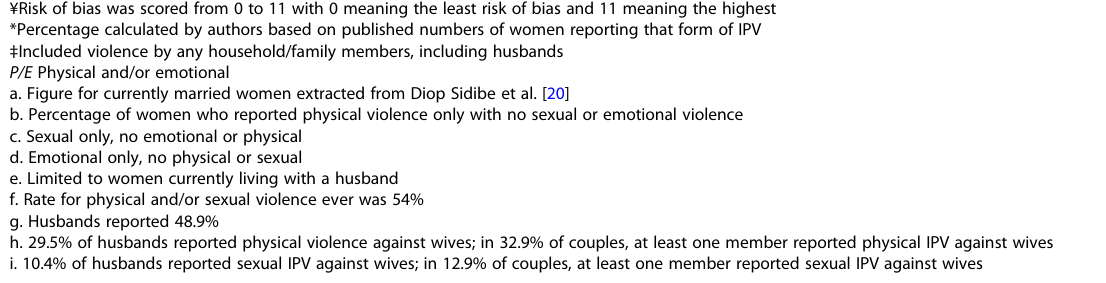
¥Risk of bias was scored from 0 to 11 with 0 meaning the least risk of bias and 11 meaning the highest *Percentage calculated by authors based on published numbers of women reporting that form of IPV ‡ Included violence by any household/family members, including husbands P/E Physical and/or emotional a. Figure for currently married women extracted from Diop Sidibe et al. [20] b. Percentage of women who reported physical violence only with no sexual or emotional violence c. Sexual only, no emotional or physical d. Emotional only, no physical or sexual e. Limited to women currently living with a husband f. Rate for physical and/or sexual violence ever was 54% g. Husbands reported 48.9% h. 29.5% of husbands reported physical violence against wives; in 32.9% of couples, at least one member reported physical IPV against wives i. 10.4% of husbands reported sexual IPV against wives; in 12.9% of couples, at least one member reported sexual IPV against